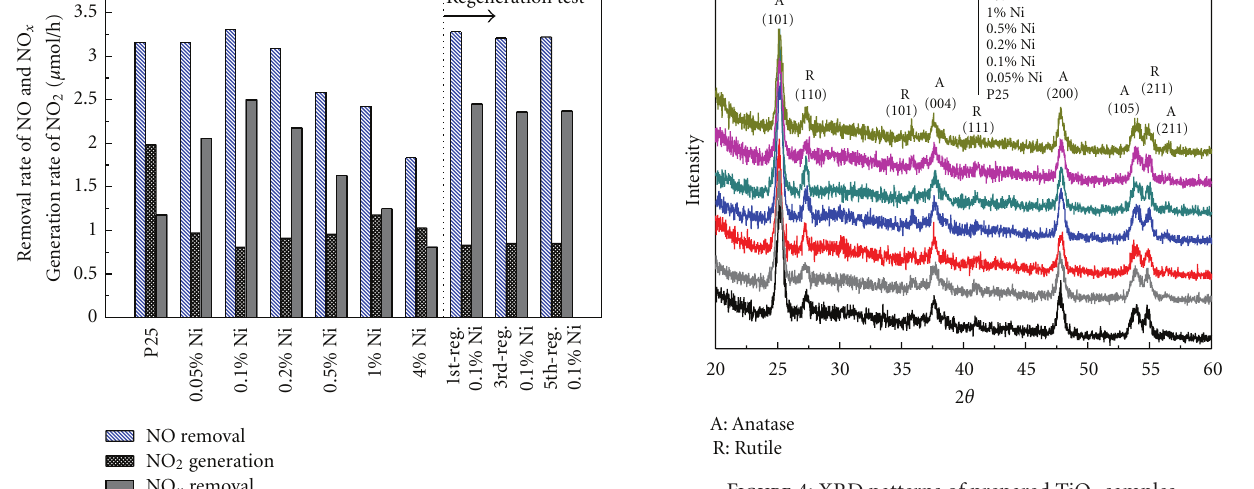
Figure 4: XRD patterns of prepared TiO 2